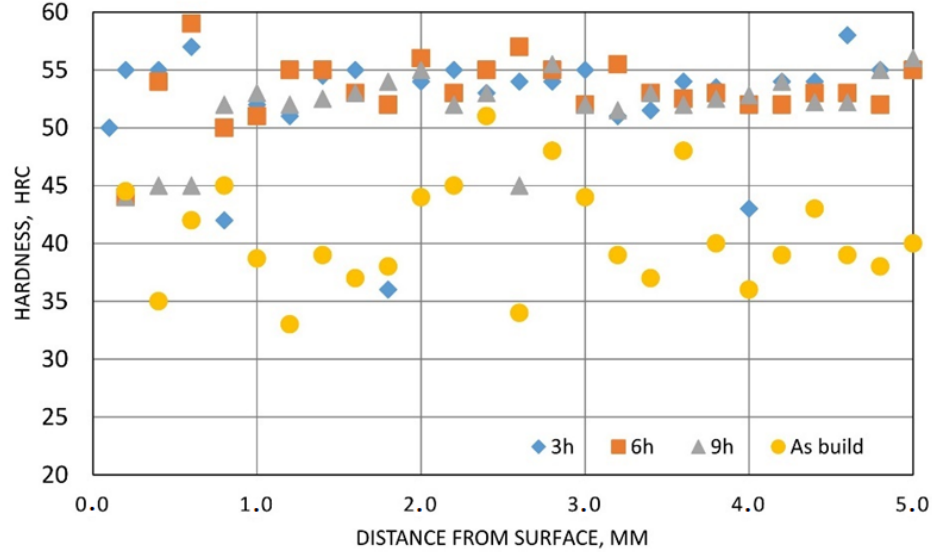
Figure 11. Hardness distribution from surface to core of the AM M789 maraging steel when subjected to aging for 3 h, 6 h or 9 h. Table 5. Mechanical properties of the printed M789 maraging steel in solution annealed and heat-treated conditions (mean value, standard deviation).